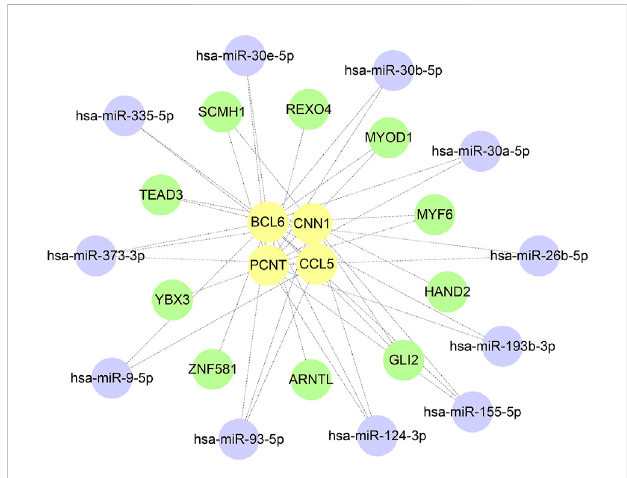
FIGURE 9 Construction of the hub gene − miRNA network and the target gene − TF network.